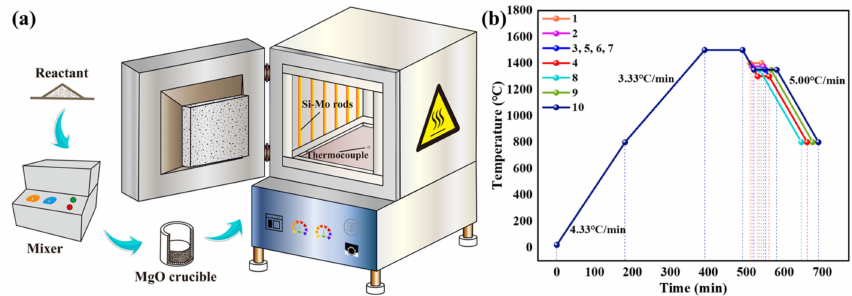
Figure 1. Experimental methods ( a ) schematic diagram of equipment, and ( b ) heating